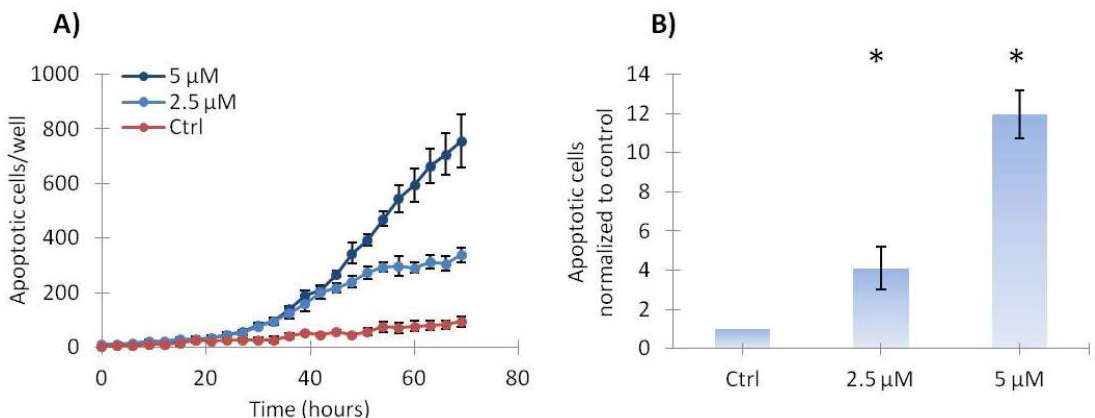
Figure 4. Vemurafenib induces apoptosis in SA-4 cells. ( A ) The number of apoptotic cells per well was determined based on caspase-3/7 activity monitored by time-lapse microscopy during treatment with 2.5 or 5 µM vemurafenib or vehicle only (Ctrl). The curve from one out of three representative experiment is shown and error bars represent standard error of mean (SEM) of three technical replicates; ( B ) Apoptotic cells shown relative to total cells, normalized to control at 72 h. Error bars represent standard deviations (SD) between biological experiments ( n = 3). * indicates p < 0.05.